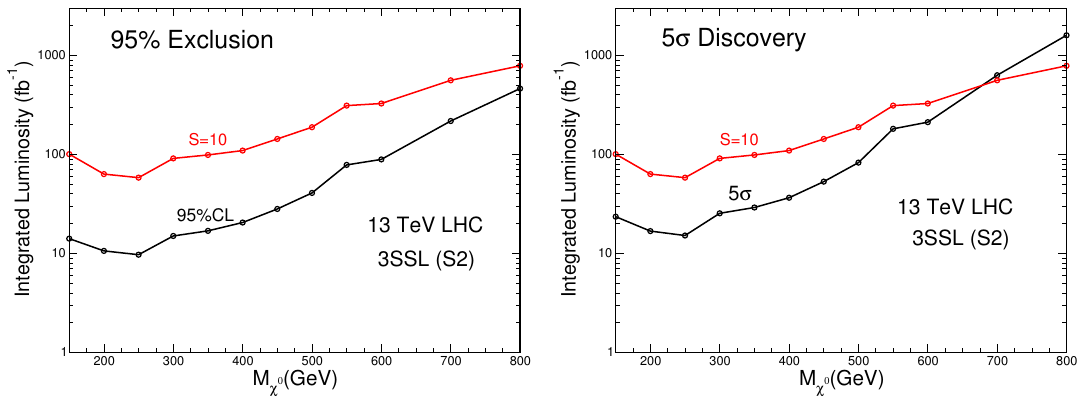
Figure 11 . The left panel shows the required integrated luminosity at the 13 TeV LHC for 95% CL exclusion ( Z exc 1.645) in the 3SSL channel after imposing S 2 selection criteria as a function of (cid:21) M . The right panel portrays the same for 5 (cid:27) discovery ( Z dis (cid:31) 0 same for any uncertainty in the background in the range 0 to 50%. In both the panels (red lines), we also show the required integrated luminosity to observe 10 signal events in the 3SSL channel.